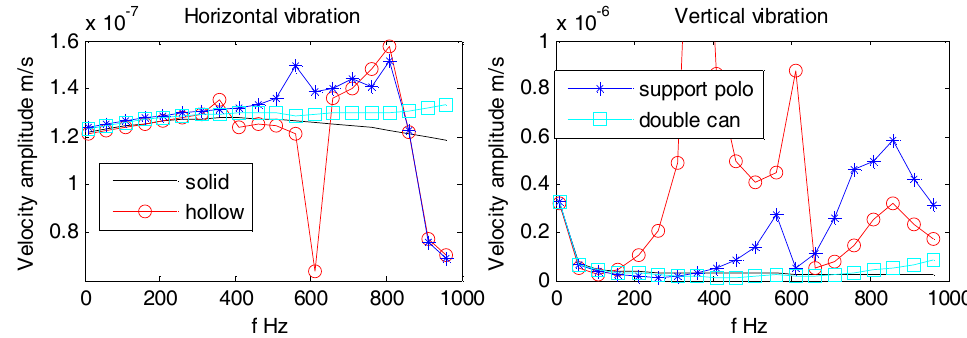
◦ . Sensors 2018 , 18 , 3446